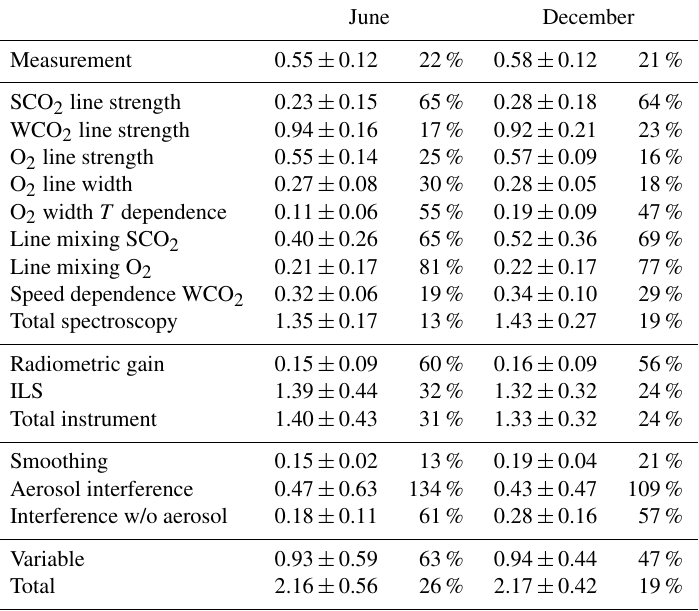
Table 3. Global mean errors in XCO 2 and standard deviations for land nadir observations. The coefficient of variation (relative standard deviation) is also shown.